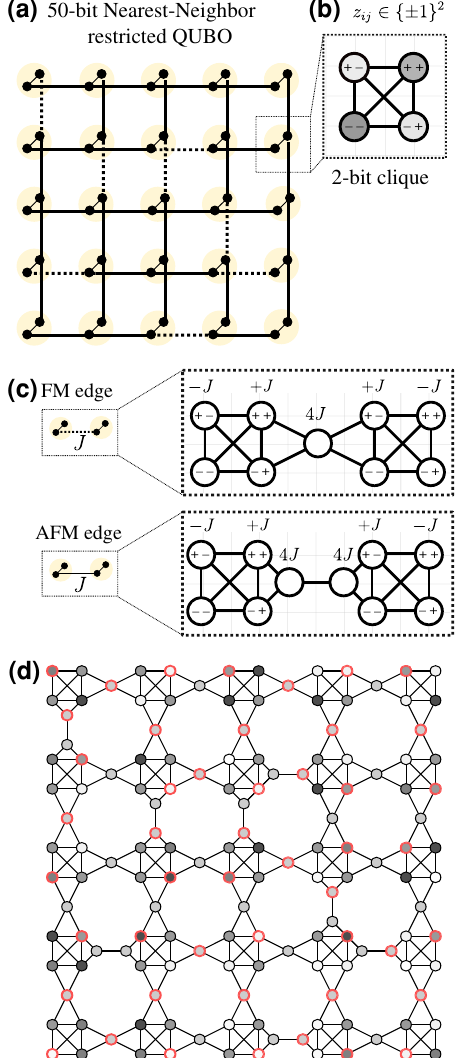
FIG. 11. An example 2D restricted-connectivity graph and reduction to UDG-MWIS. (a) A particular topology of bits (ver- tices) and quadratic terms (edges). The original graph can be mapped into a UDG-MWIS using some gadgets. (b) Two bits can be represented by a clique of four vertices, with each state ( ±± ) represented by a single vertex of the clique. Linear and quadratic interactions are represented by biasing the weights of the